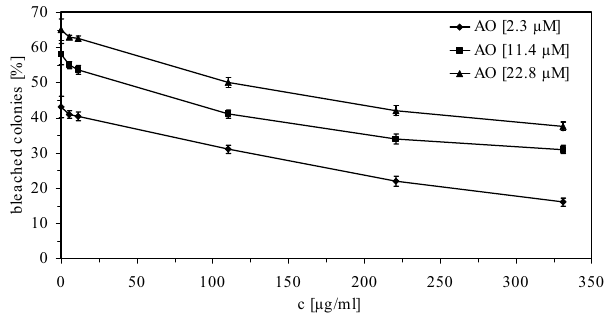
Figure 2 A plot of percentage of bleached colonies of E. gracilis vs. concentration of M. aquifolium extract at 3 concentrations of acridine orange (AO). Symbols and brackets denote means ± standard deviation of 3 independent determinations.